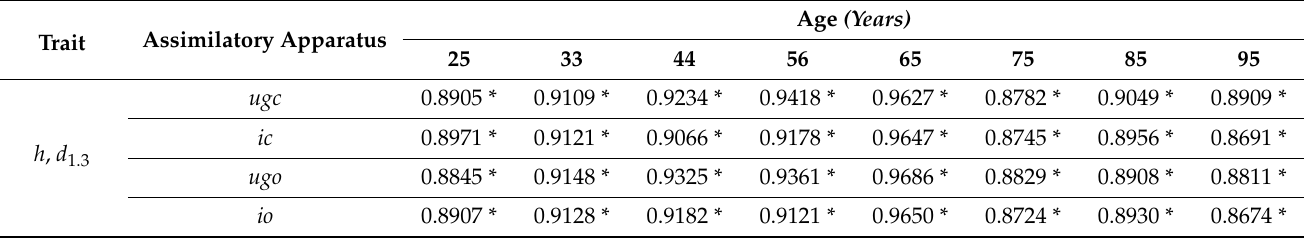
Table 11. Values of multiple correlation coefficients R between the size of the assimilatory apparatus ( ugc , ic , ugo , io ) and dendrometric traits ( h and d 1.3 ) depending on the age of